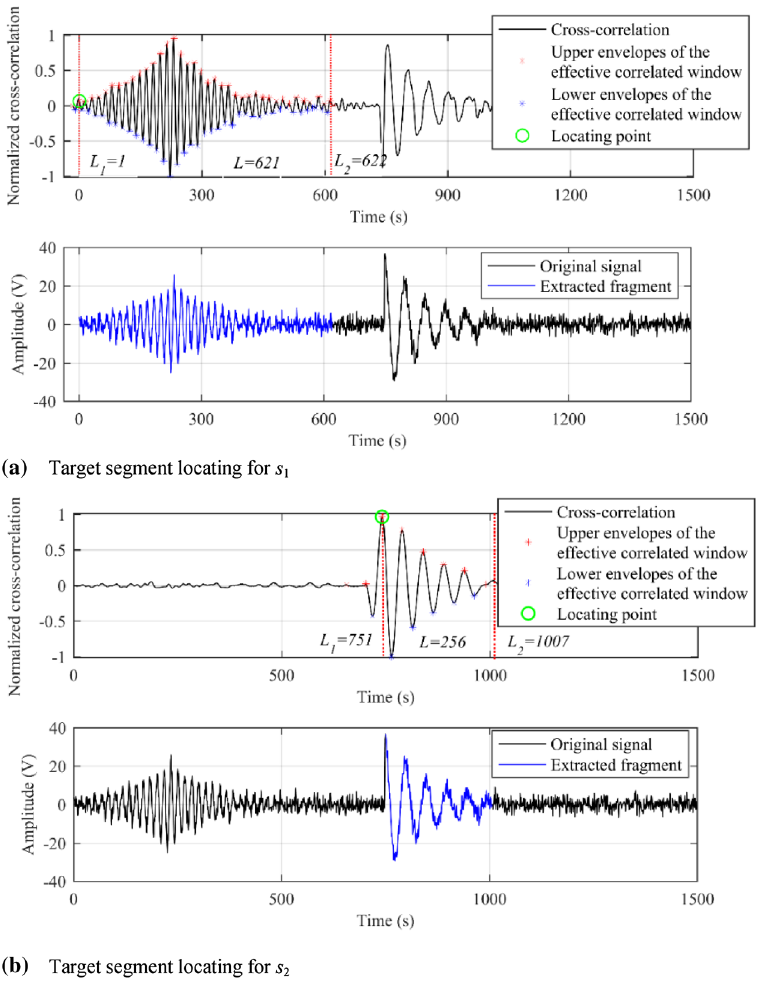
Figure 7. Target segment extraction based on correlation detection technique. The upper and lower subplot denoted the segmentation result of signal components s 1 and s 2 , respectively. In the upper subplots, the black solid lines are cross-correlation functions; red and blue scatters describe the envelopes of the effective correlated windows; and red dotted line are calculated time range. The green cycles indicate the start–end of the target segments.